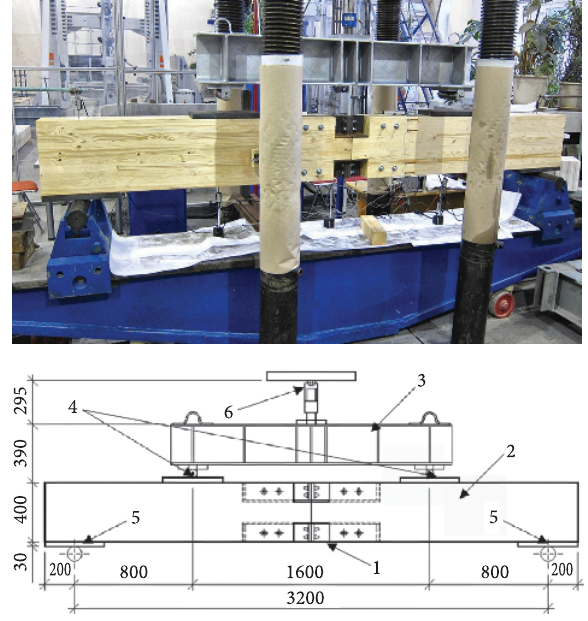
Fig. 5. Connection test scheme: 1 – analyzed joint; 2 – timber element; 3 – spanner; 4 – load addition points; 5 – pinned supports; 6 – the